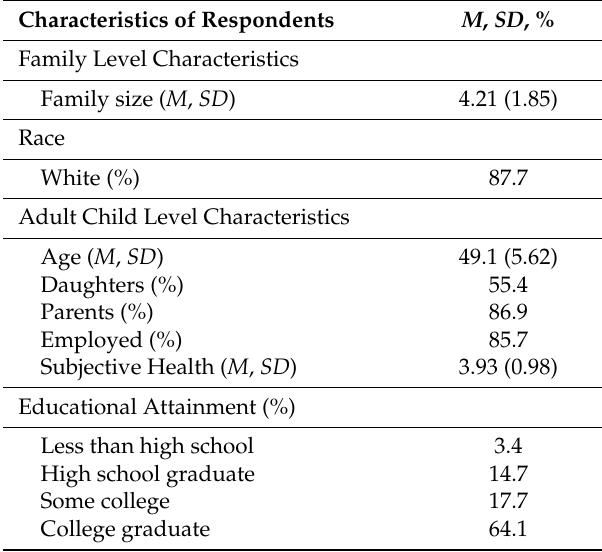
Table 1. Sample characteristics (N =